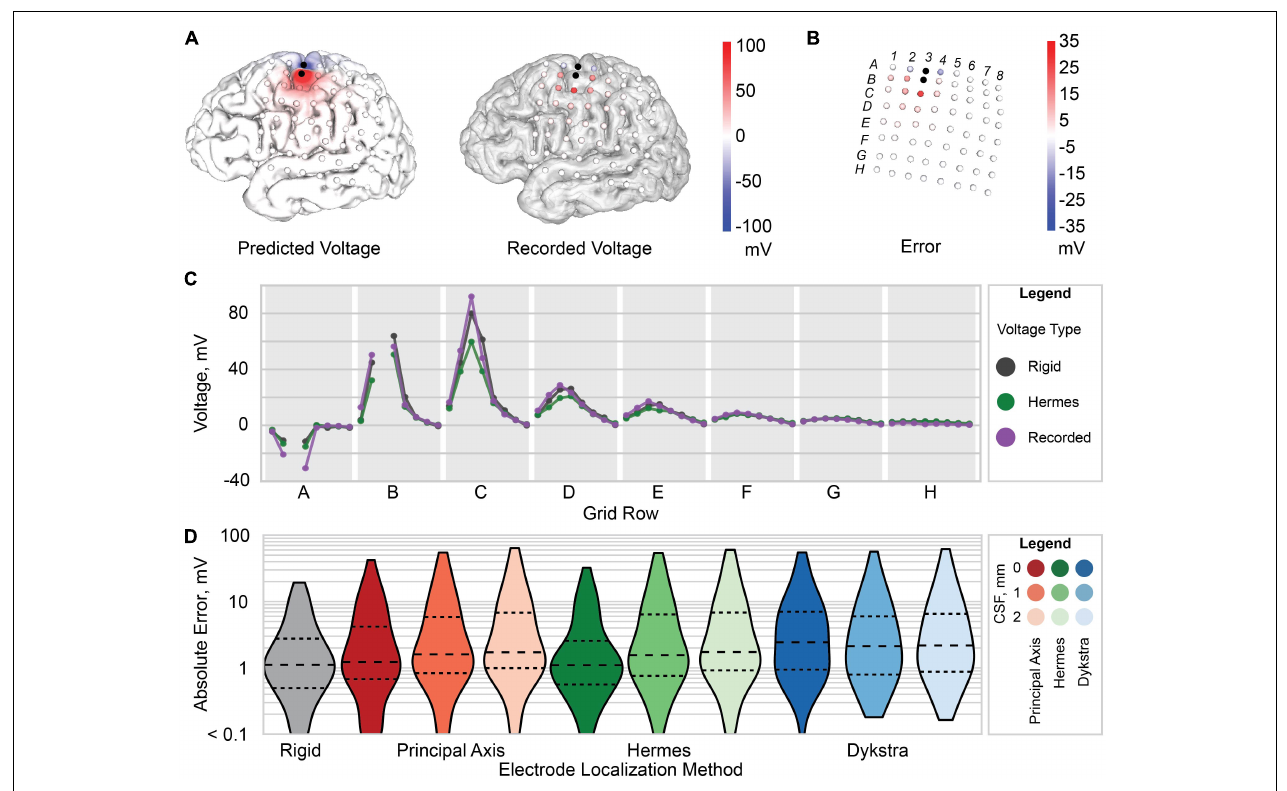
FIGURE 5 | Voltage and error for patient 3. (A) Predicted voltage on the gray matter surface ( left ) and recorded voltage at each recording electrode ( right ). (B) Raw error (predicted voltage subtracted from the recorded voltage) at each electrode. (C) Predicted voltage for the Hermes method with 0 mm CSF (green), rigid model (gray), and recorded voltage (purple). Each gray region marked with a letter represents a row of electrodes on the ECoG grid [labels shown in panel (B) ]. (D) Violin plot of the absolute error between the predicted and recorded voltages for each electrode localization method: rigid (gray), principal axis (red), Hermes (green), and Dykstra (blue) with 0, 1, and 2 mm of CSF from left to right for each method. The dashed line is the median, and smaller dashed lines demark the interquartile